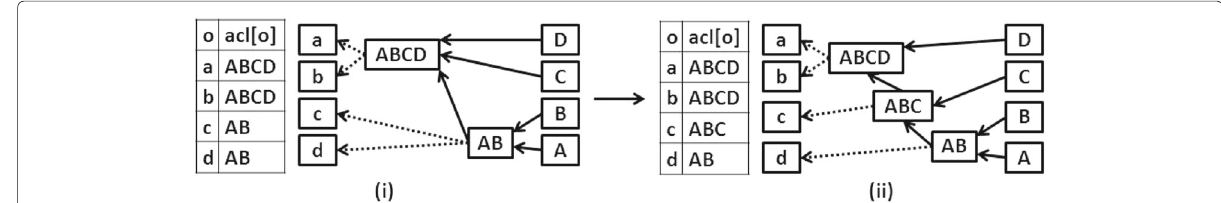
Fig. 9 Modified example of minimal vertex user hierarchy ( i ) before, and ( ii ) after granting read